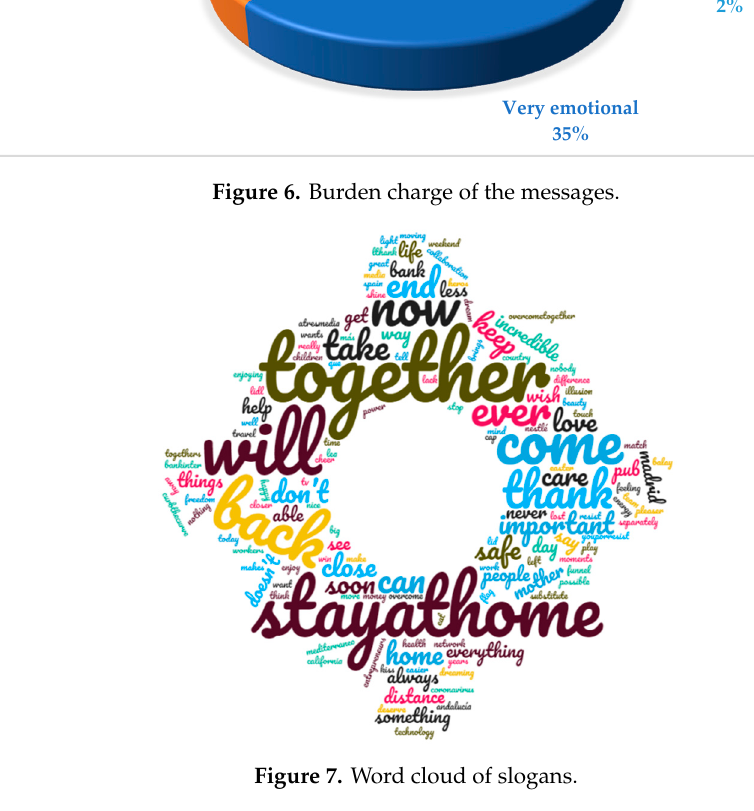
Figure 6. Burden charge of the messages.